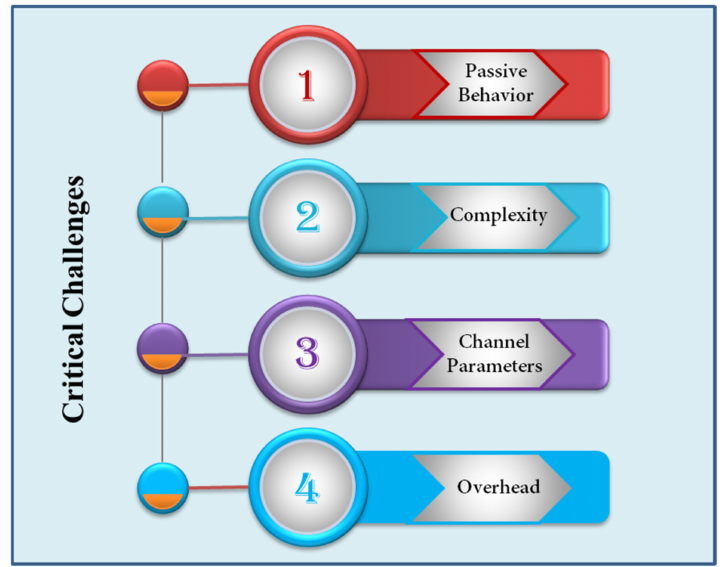
Figure 16. Crucial challenges in IRS channel